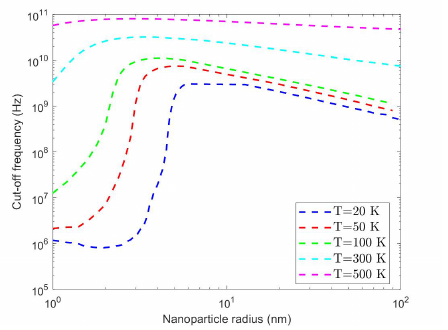
Figure 14. Cutoff frequency versus R , fnp =